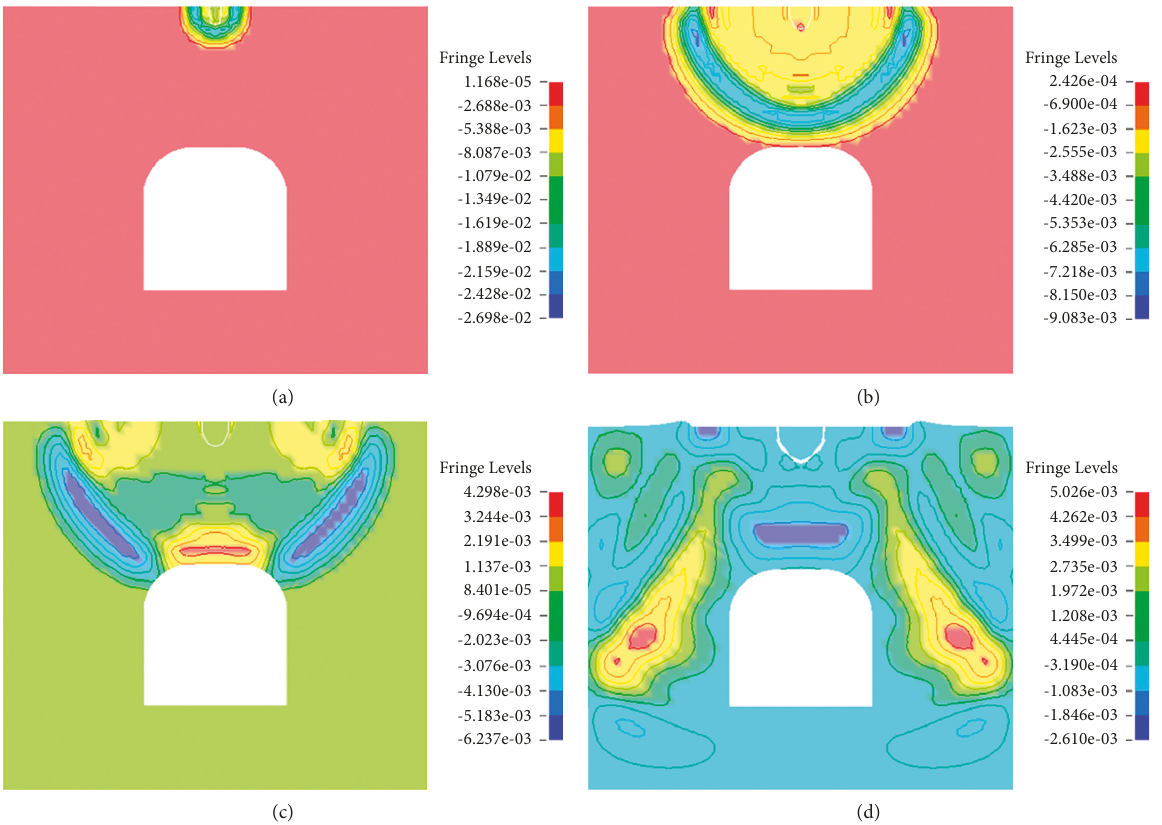
Figure 7: Blasting waves’ propagation in intact surrounding rock. (a) Stress propagation within 30 μ s. (b) Stress propagation within 120 μ s. (c) Stress propagation within 400 μ s. (d) Stress propagation within 660 μ